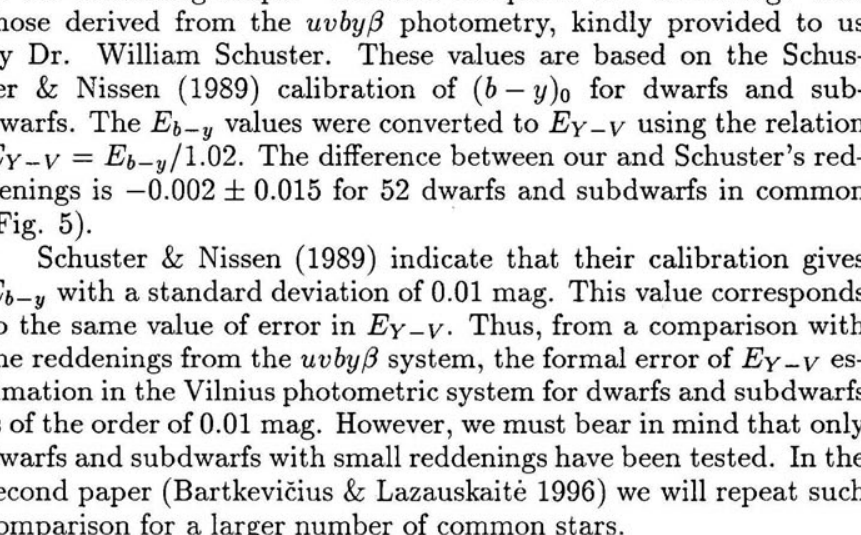
-v determined from the Vilnius and uvbyp Y